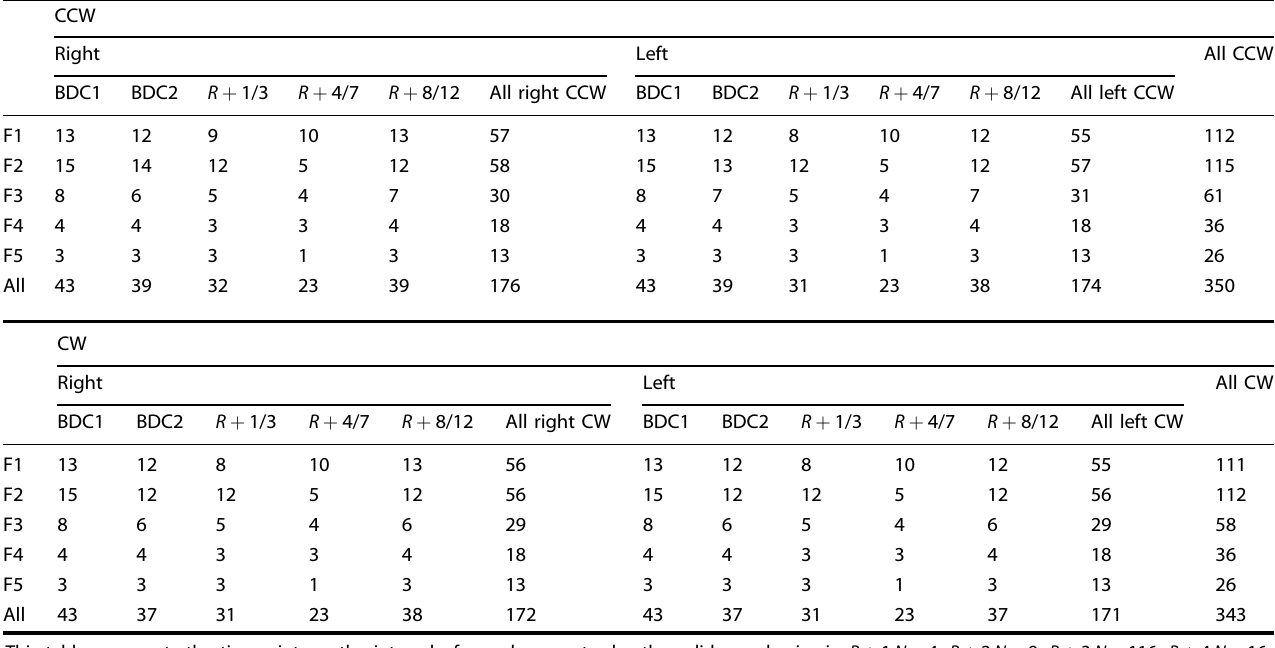
Table 2. Overview of the valid number of data points for each fl ight, rotation, eye, and timepoint. CCW Right